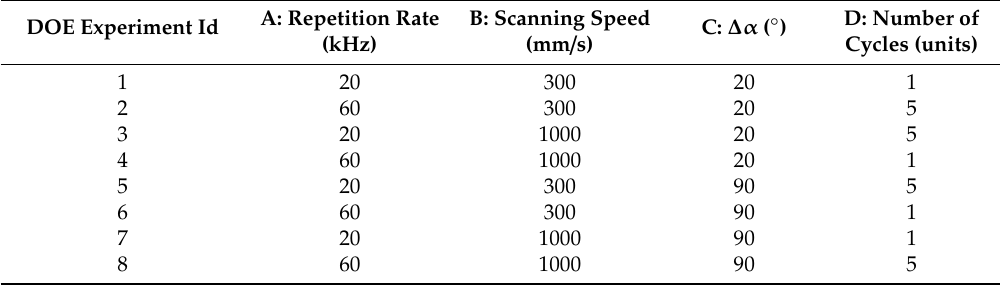
Table 3. Design of experiments with four factors: A: repetition rate (kHz), B: scanning speed (mm / s), C: ∆ α ( ◦ ), and D: number of cycles (units). DOE: design of experiments. DOE Experiment